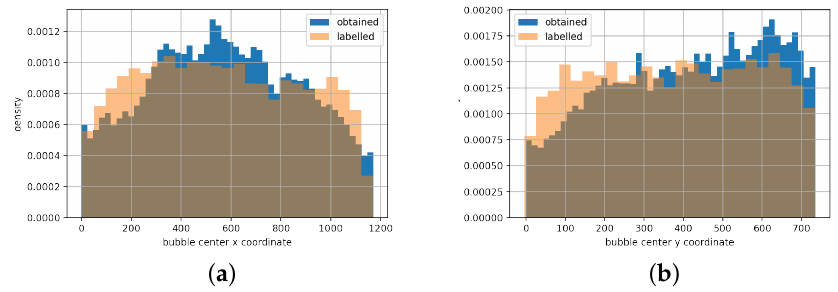
Figure 21. Comparison of the distributions for horizontal ( a ) and vertical ( b ) coordinates of bubble’s center for the computer vision method (blue) and labelled results